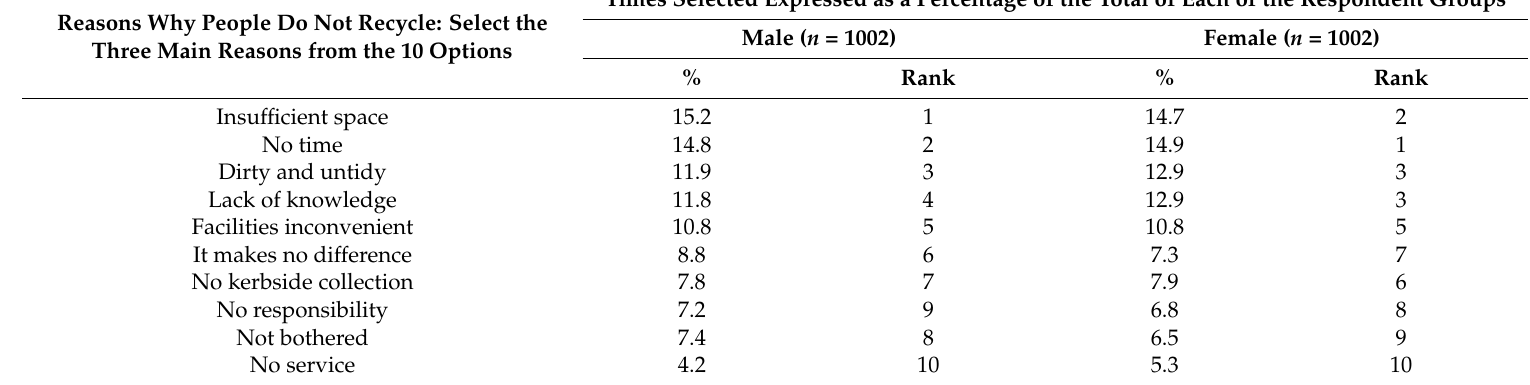
Table A2. Reasons why people do not recycle as enumerated per gender group ( n =